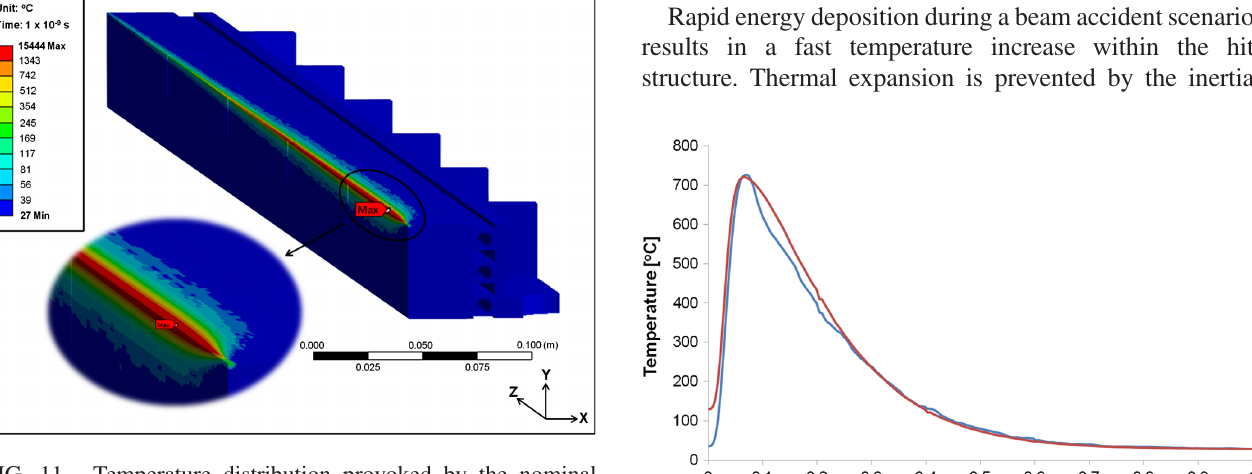
FIG. 11. Temperature distribution provoked by the nominal proton beam impact at 1 ns. The red region represents temper- atures that exceed the melting temperature of INERMET ® 180 ( ∼ 1343 °C) and is thus an indication of the extent of the groove formation on the surface of the collimator jaw inserts. A detailed view is shown in the inset.